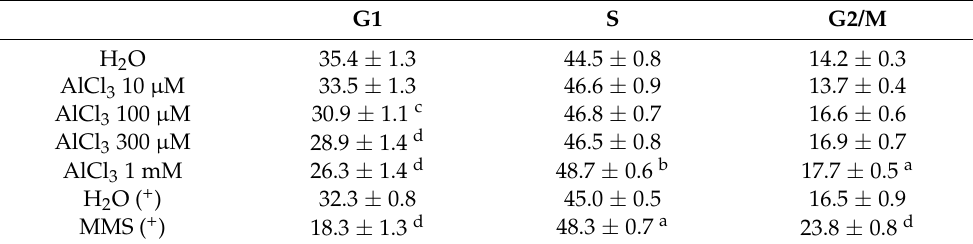
Table 1. Cell cycle analysis of V79 cells exposed to